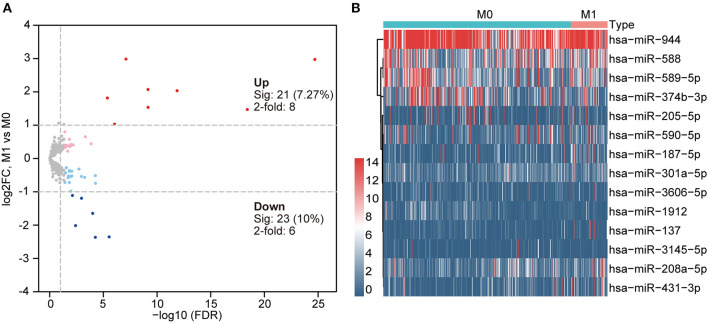
(A) Volcano plot indicating differentially expressed miRNAs (DEmiRNAs) in primary COAD patients and metastatic COAD patients (light red and blue colors indicate adj. p < 0.05 (sig), whereas red and blue further require more than a 2-fold change); other genes are colored in gray. (B) Heat map of DEmiRNAs in primary COAD patients and metastatic COAD patients. Red, higher expression. Blue, lower expression.